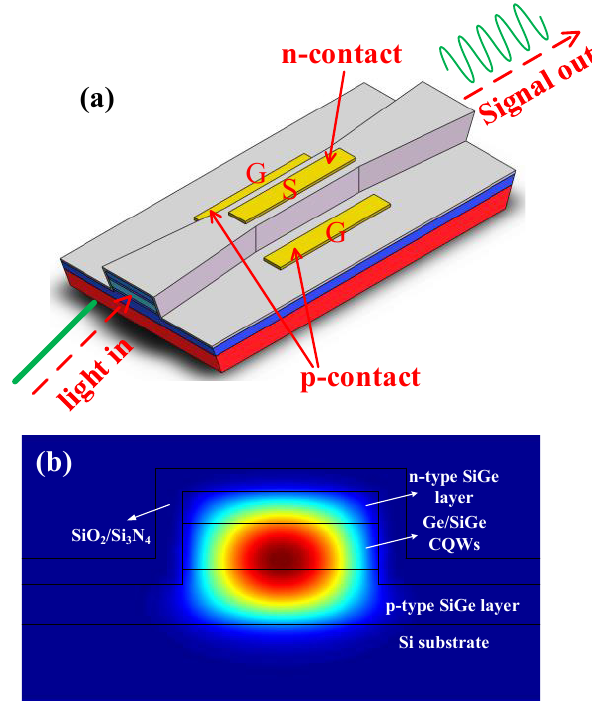
Figure3: (a)Schematicofthedevice.(b)Thefielddistributionofthe fundamental mode in the device